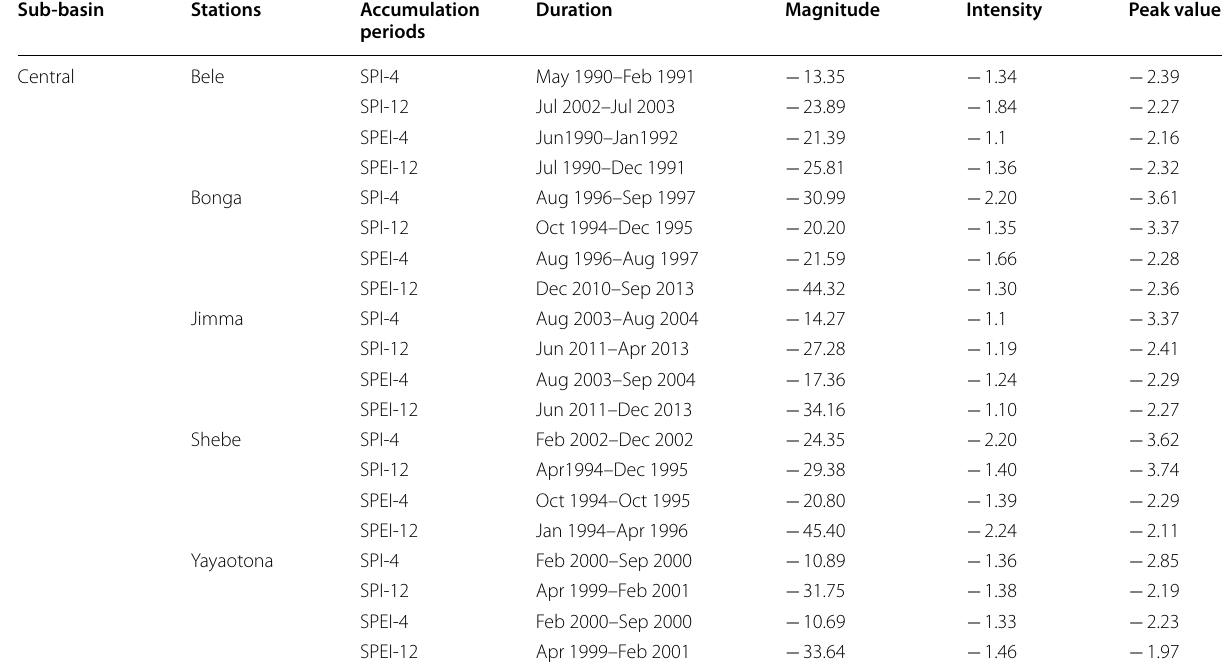
1) duration, magnitude, intensity, and peak value at the central part of OGRB ≤ −